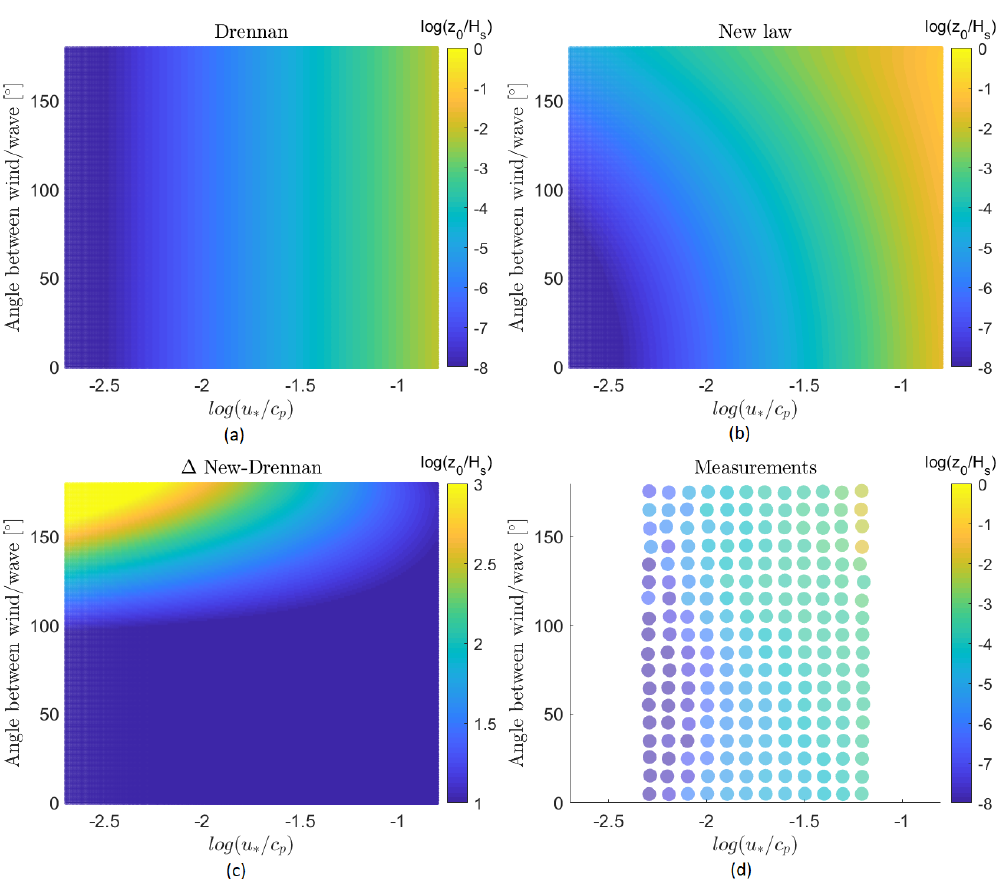
Figure 9. (a) Dimensionless roughness length as a function of the inverse wave age and the alignment between the wind and wave directions according to Drennan et al. (2003). (b) The new proposed dimensionless roughness length as a function of the inverse wave age and the alignment between the wind and wave directions. (c) The differences in roughness length between the law of Drennan et al. (2003) and the new proposed roughness length parameterization as a function of the inverse wave age and the alignment between the wind and wave directions. (d) Dimensionless roughness length for the measurements of FINO1 and ASIT as a function of the inverse wave age and alignment between the wind and wave